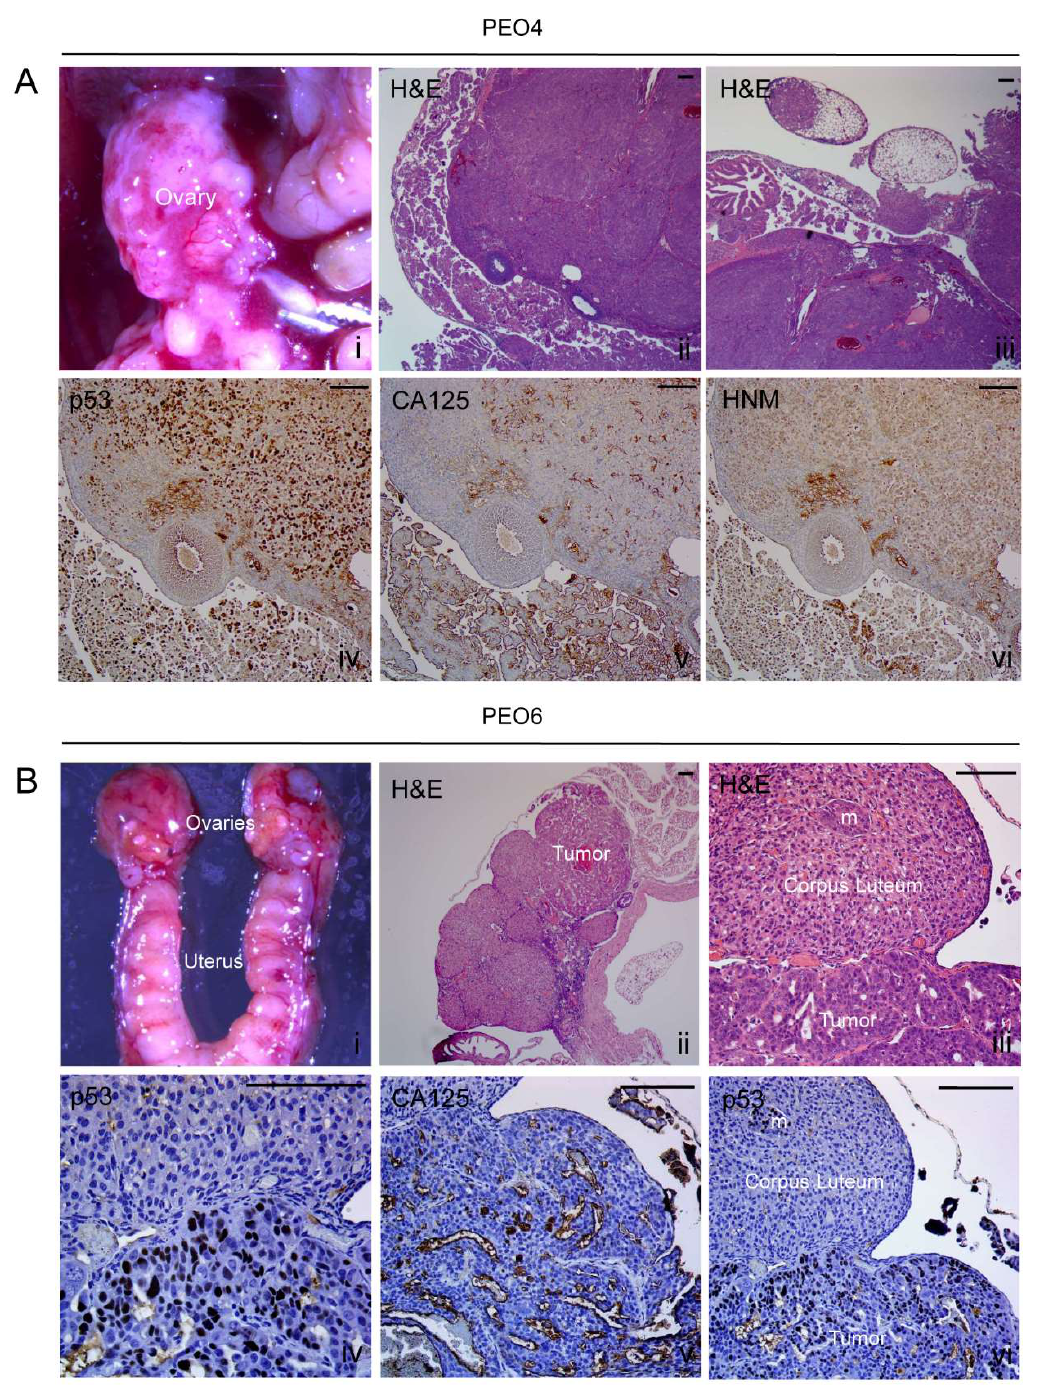
Figure 6. Metastases to the ovaries. ( A ) PEO4 cells occupy the ovary and shows positivity for the expression of mutant p53, CA125, and HNM. ( B ) PEO6 cells formed a tumor within the ovary. Higher magnification shows the clear limit between the luteal tissue and the tumoral area, and the positivity of the tumor cells for p53 and CA125 ([iv,v]). Notice the p53 positive cells identifying an isolated metastasis (m) within the corpus luteum ([vi]). Scale bars = 100 μm.